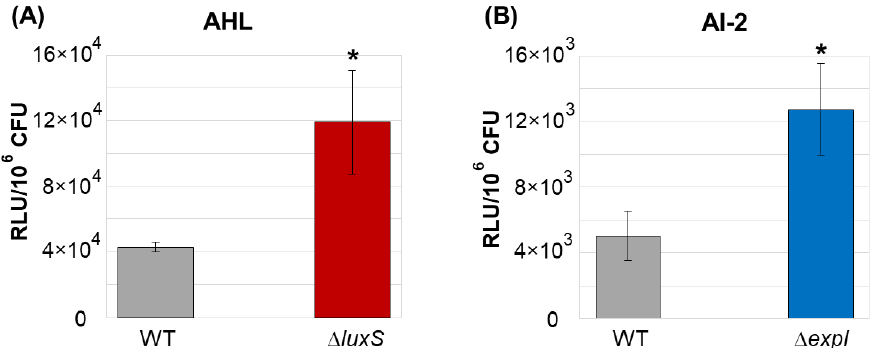
Figure 5. The levels of acyl homoserine lactones (AHL) ( A ) and autoinducer-2 (AI-2) ( B ) in the supernatants of starving cultures of Pectobacterium atrosepticum that passed through adaptive proliferation. AHL was measured in the wild type strain (WT, grey column) and AI-2-deficient Δ luxS mutant ( Δ luxS , red column) ( A ); AI-2 was measured in the wild type strain (WT, grey column) and AHL-deficient Δ expI mutant ( Δ expI , blue column) ( B ). The presented values are the means ± SD of three biological replicates. Asterisks (*) show a significant difference (Mann – Whitney two-sided test, p < 0.05).